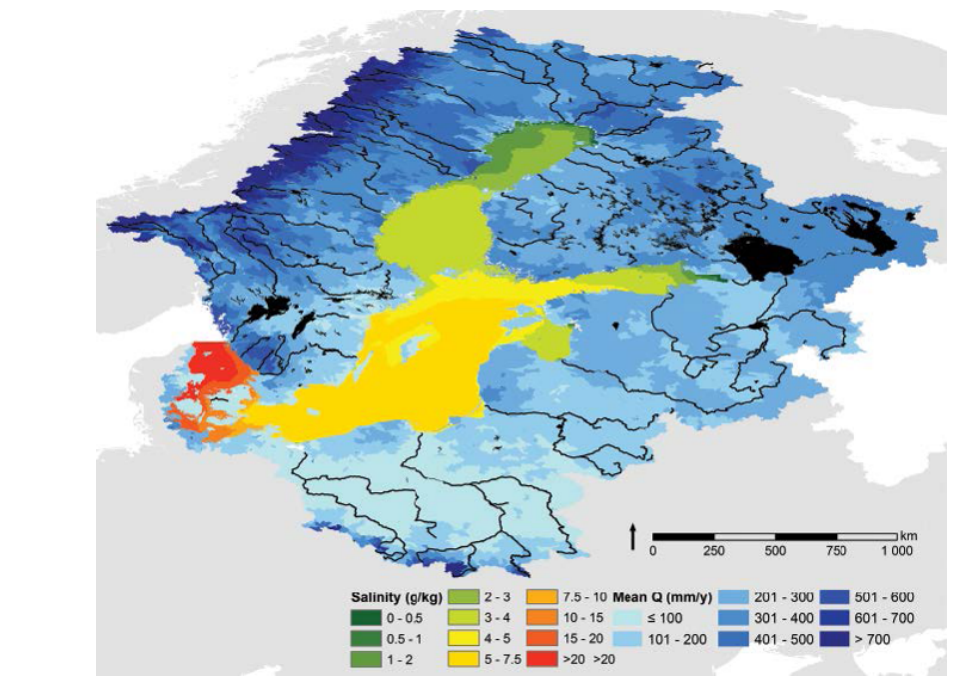
Figure 1. The Baltic Sea and its catchment area with climatological mean sea surface salinity (in gkg − 1 ) and river discharge (in mmyr − 1 ). (Source: Meier et al., 2014; their Fig. 1 distributed under the terms of the Creative Commons CC-BY 4.0 License, http://creativecommons. org/licenses/by/4.0/, last access: 4 February